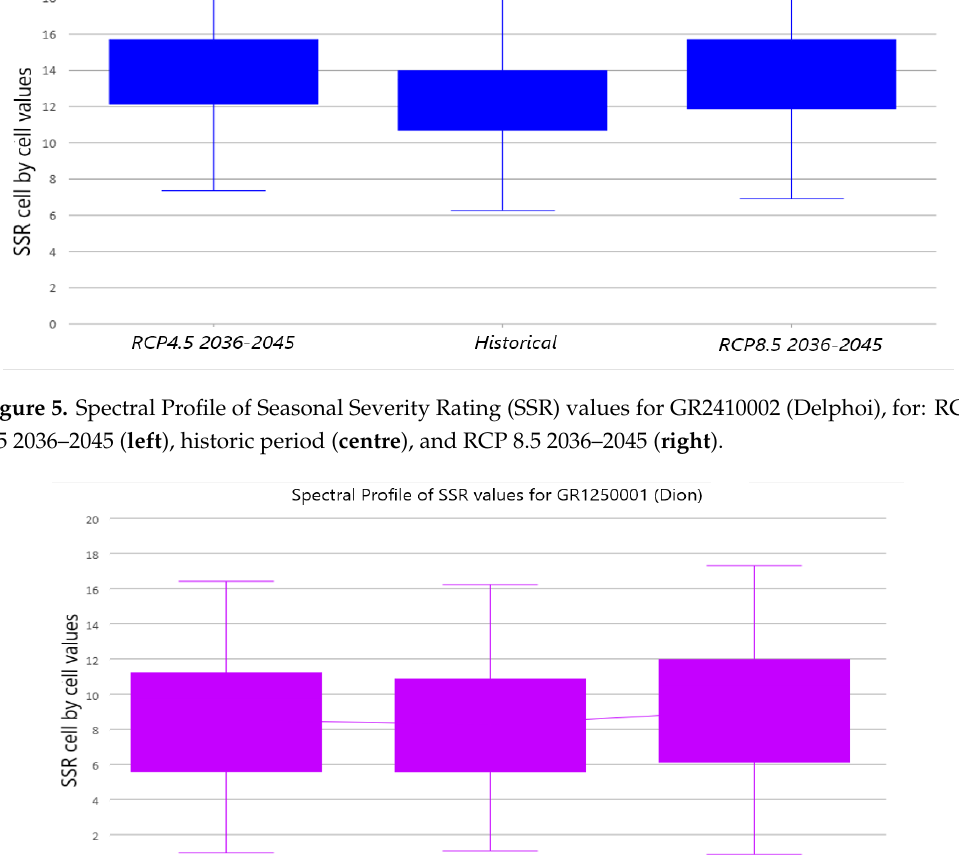
Figure 7. Maps of coloured Areas of Interest (AoI) depicting classified Seasonal Severity Rating (SSR) Mean values, for: ( a ) the historic period, ( b ) RCP 4.5 2036–2045, ( c ) RCP 8.5 2036–2045.